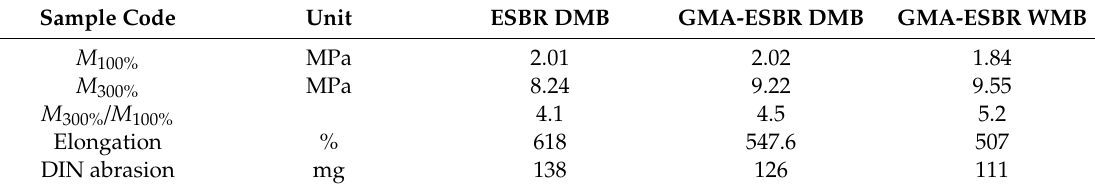
Table 9. Viscoelastic properties of ESBR DMB, GMA-ESBR DMB, and GMA-ESBR WMB compounds.